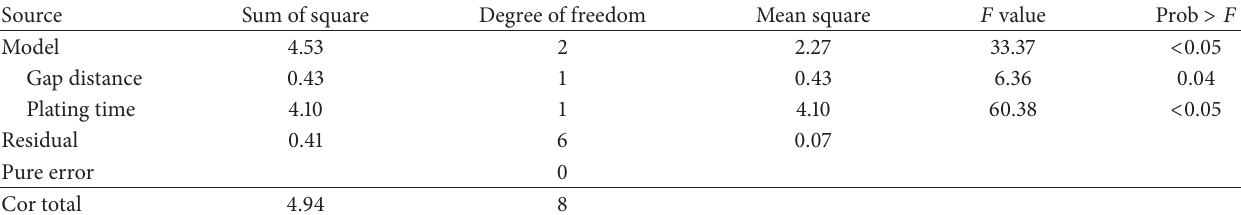
Table 3: Analysis of variance for the coating thickness uniformity.